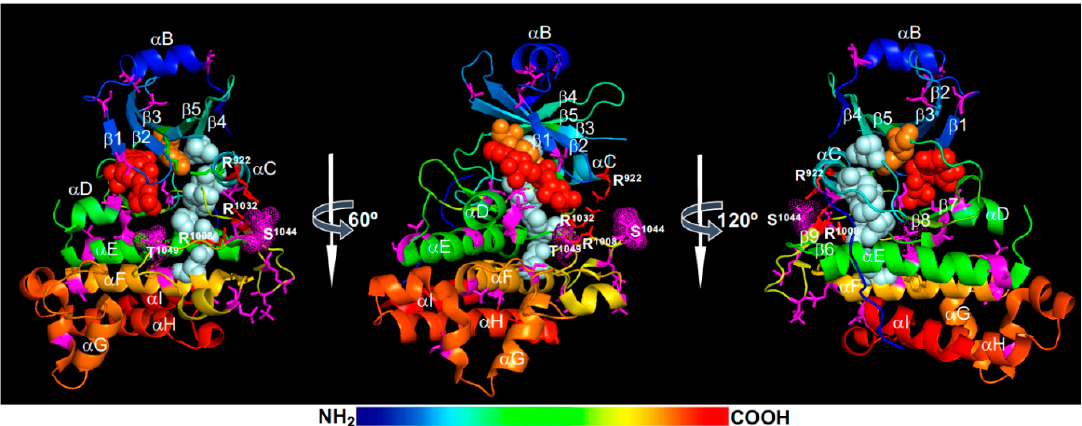
Figure 2. A structural model of the activated BRI1 kinase domain. Shown here are three (0°, 60°, and 180°) rotational views of a rainbow-colored ribbon model of the crystal structure of the BRI1 kinase domain (Protein Data Bank No. 4oh4). Individual α -helices ( α B- α I) and β -strands ( β 1- β 5) were labelled. The magenta-colored sticks indicate phosphorylated Ser/Thr residues with the magenta dots surrounding Ser 1044 and Thr 1049 of the activation segment, the green sticks denote the Lys 911 and Glu 927 residues that form the salt bridge between the β 3-strand and α C-helix, the red sticks mark the three positively charged residues of the phosphate-binding pocket, and the orange sticks represent the phosphorylated Tyr residue. The red spheres show adenylyl-imidodiphosphate (a non-hydrolysable ATP analog), the orange spheres indicate the gatekeeper Tyr 956 residue that is also phosphorylated in in vitro assays, and the light-blue spheres denote the five regulatory-spine (R-spine) residues (from lower to upper: Asp 1068 , His 1077 , Phe 1028 , Ile 931 , and Leu 942 ). The rainbow bar indicates the order of amino acids (AAs) from the N-terminus (blue) to the C-terminus (red).